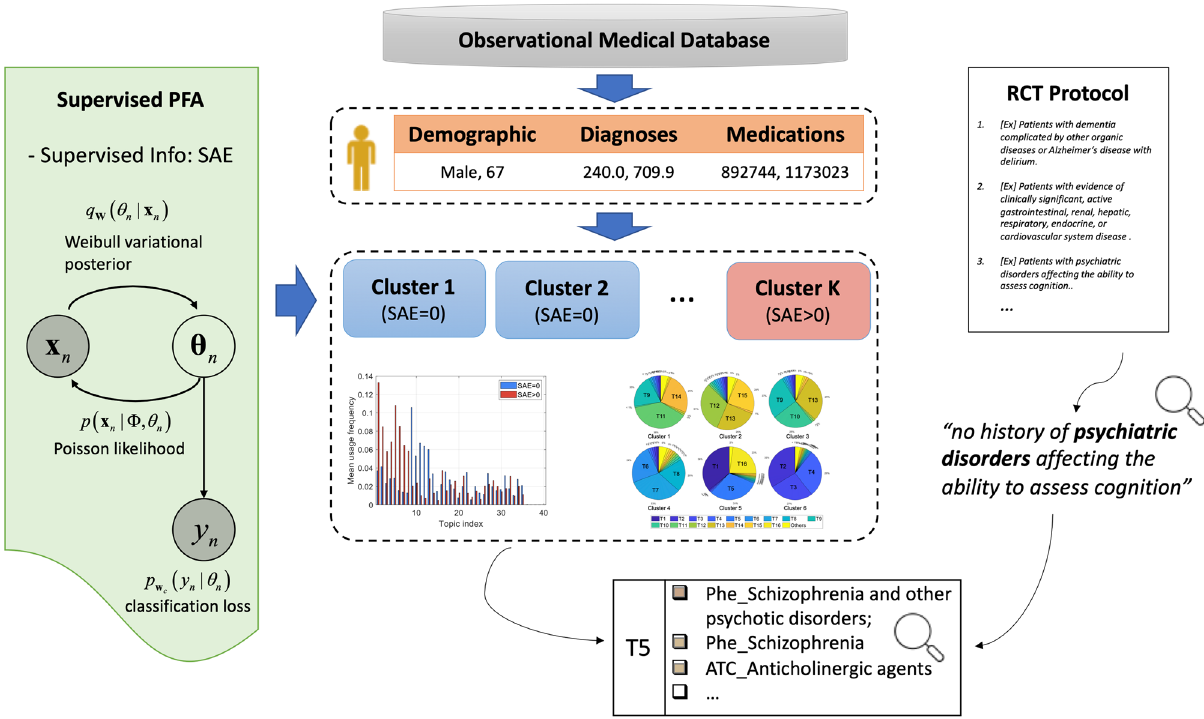
Figure 1. Model overview. Demographics, diagnoses, and medications were extracted from RWD to represent patients. Supervised Poisson factor analysis (PFA) was applied to identify patient subgroups with coherent clinical latent topics and outcomes measured by SAEs. Subgroups with SAEs can be derived to inform the design of clinical trial exclusion